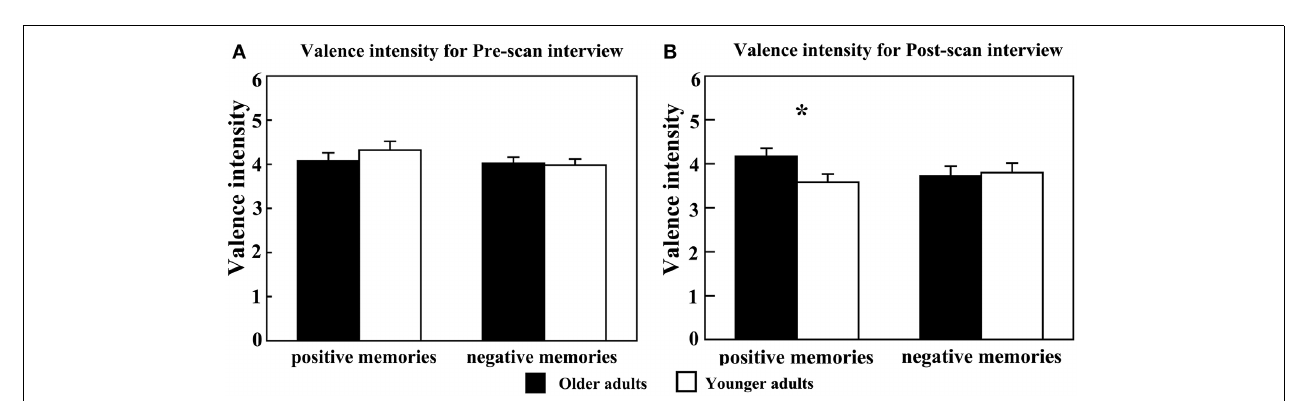
positive and negative memory retrieval. (C) Coronal, axial and sagittal views showing the selected ROI of the VMPFC/ACC. (D) Average z-scores within the VMPFC/ACC of the two groups during the positive and negative memory retrieval. Error bars represent standard error values. ∗∗ p < 0 . 05; ∗ 0 . 05 < p < 0 . 1.